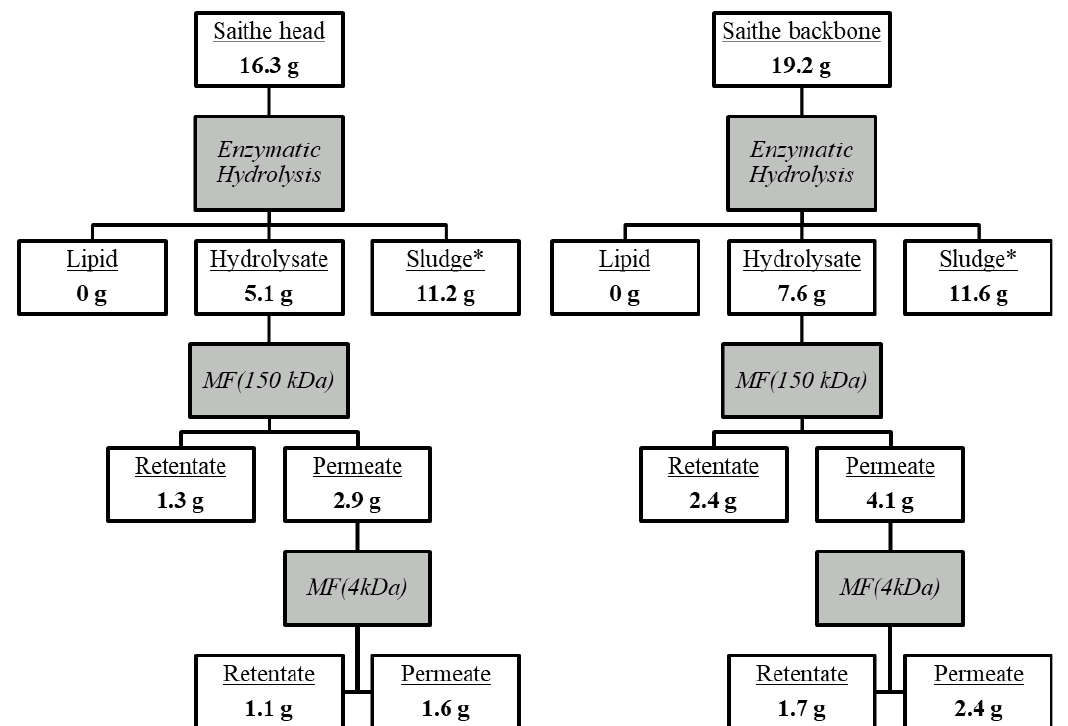
Figure 2. Protein flow (g) from raw material to product after processing of 100 g minced saithe heads ( left ) and backbones ( right ) by enzymatic hydrolysis [3] and filtration with a 150 kDa cut-off ceramic membrane followed by a 4 kDa cut-off PESH membrane. *Calculated value .